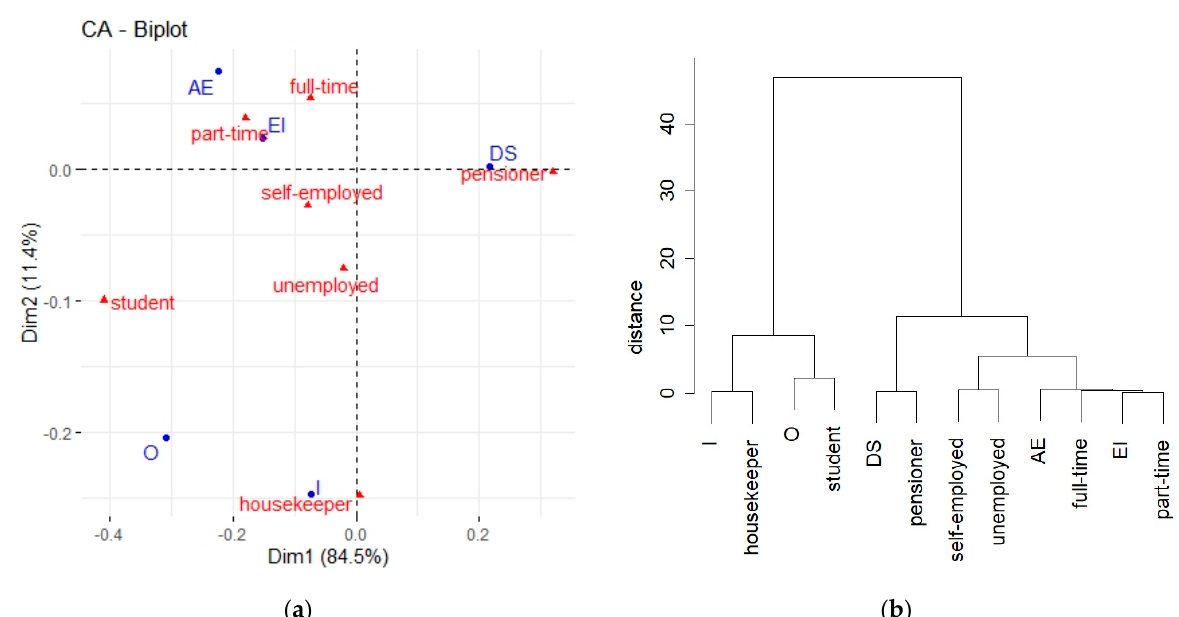
Figure 3. Correspondence map ( a ) and an auxiliary dendrogram ( b ) showing the dependence of each behavioural type of energy consumer on their professional status.